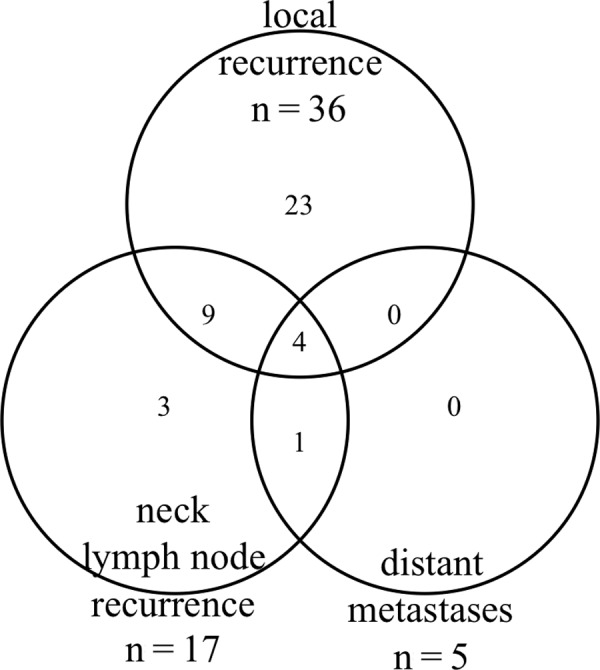
Recurrence pattern of 83 patients with sebaceous carcinoma after radiotherapy.